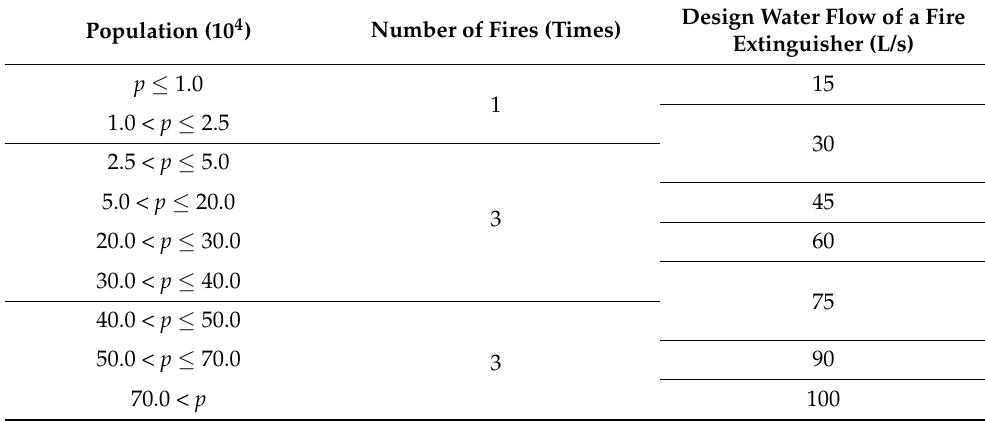
Table 2. Number of simultaneous fires and design water flow for fire extinguishing in towns and residential areas